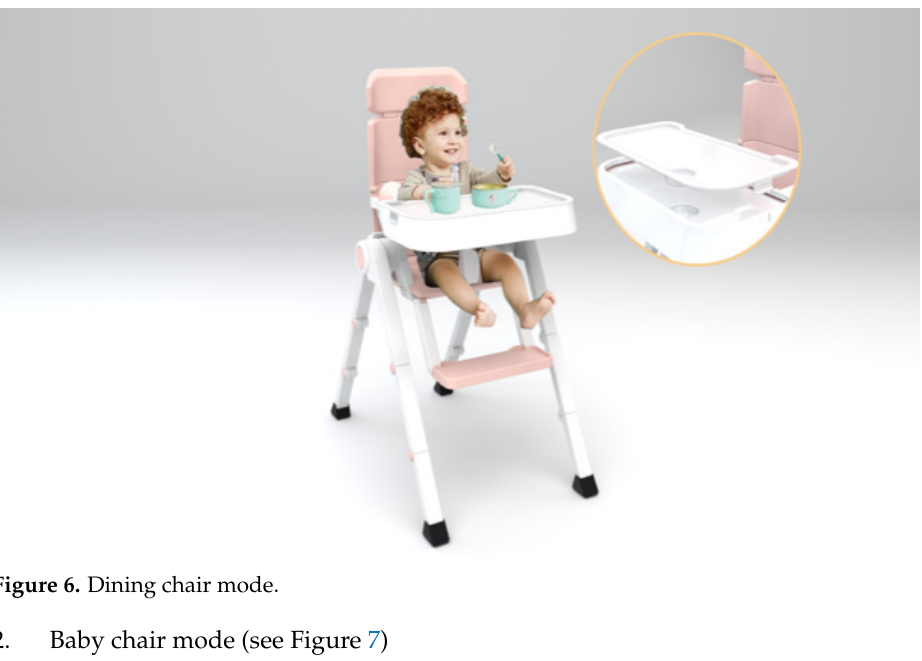
Figure 6. Dining chair